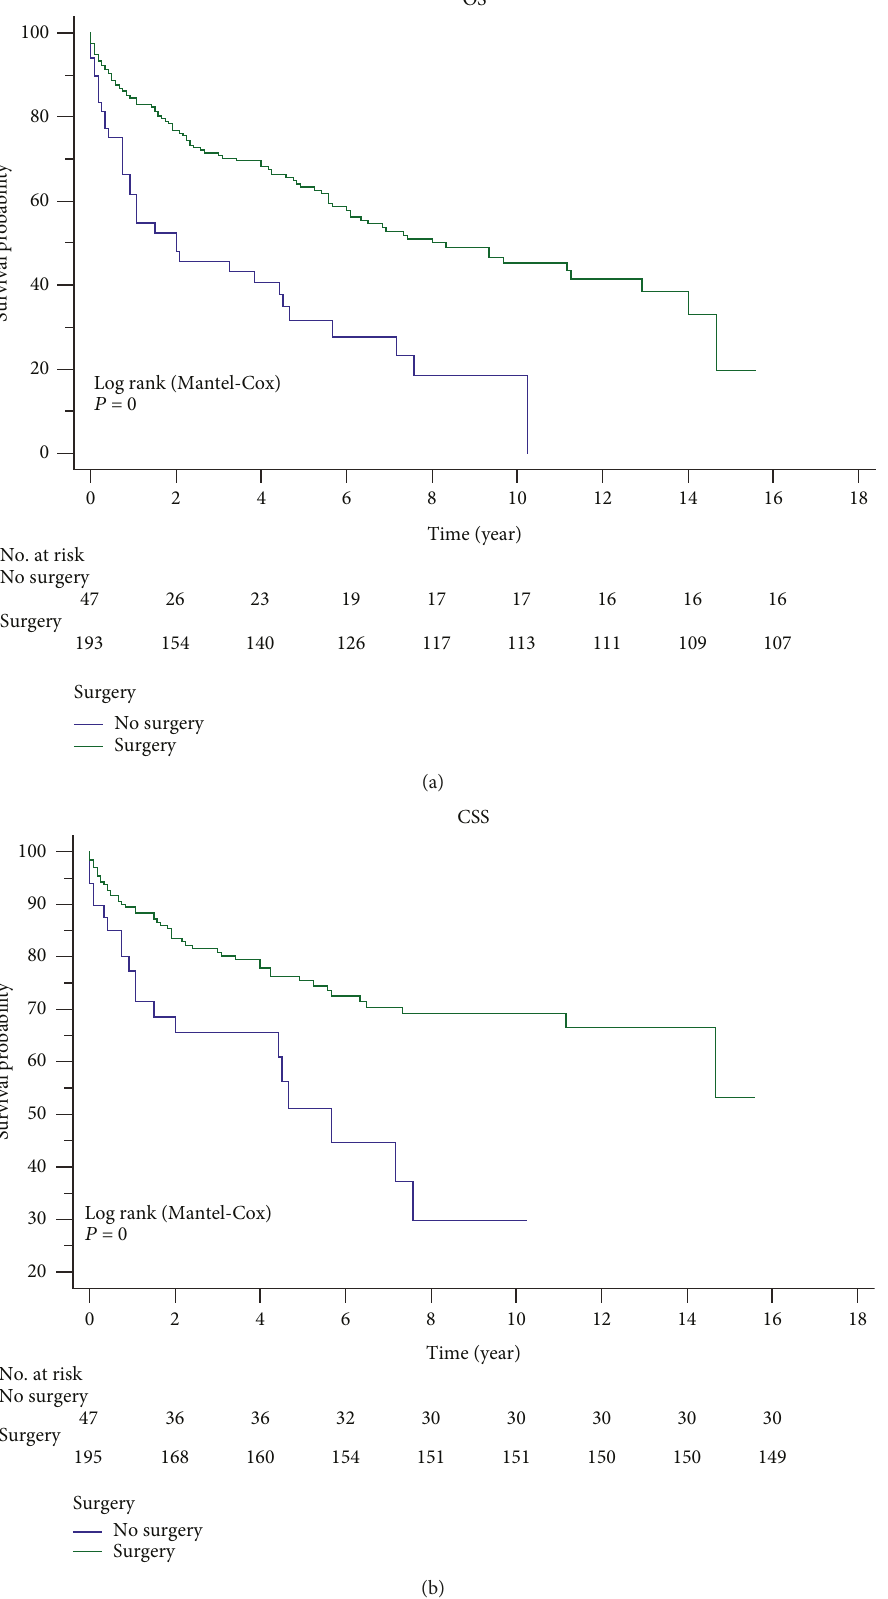
Figure 3: Surgery signi fi cantly improved the OS and CSS rates via Kaplan-Meier analysis of colonic